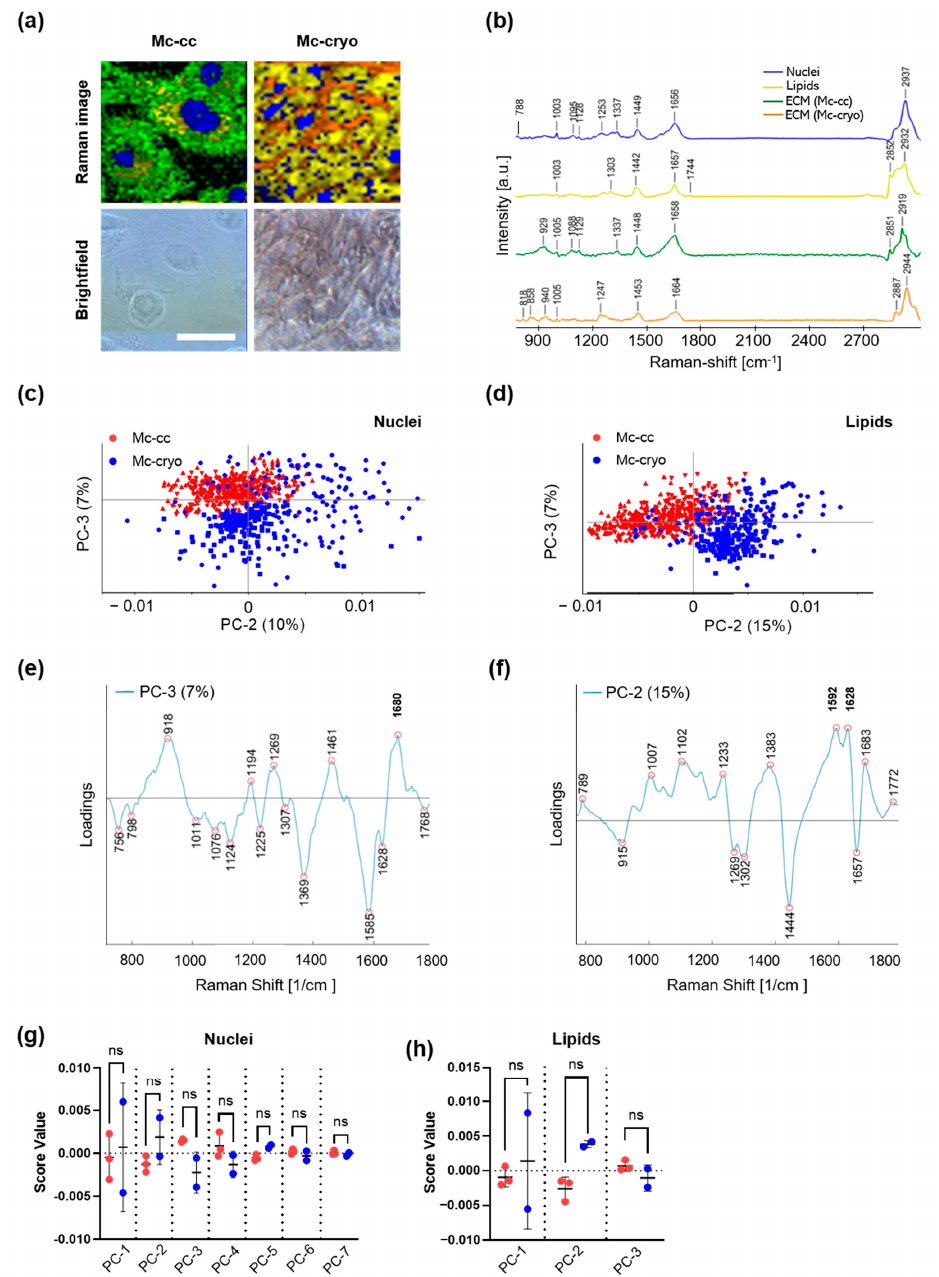
Figure 4. Raman imaging and multivariate data analysis of PWC-derived mesothelial cell culture (MC-cc) and cryo-fixed peritoneal tissue (MC-cryo). MC-cc were cultured on dishes, fixed with PFA and imaged in PBS using a customized upright WITec alpha300 R Raman system. MC-cryo were washed and imaged. MC-cc and MC-cryo were compared by multivariate data analysis with a focus on nuclei (DNA), lipids, and ECM components. ( a ) Representative Raman images and brightfield images of MC-cc and MC-cryo. Scale bar represents 50 µ m. ( b ) Characteristic fingerprint spectra of the analyzed molecular components, utilized to identify nuclei/DNA (blue), lipids (yellow) and ECM (MC-cc, green; MC-cryo, orange) components by TCA. ( c ) Principal component analysis (PCA) scores plot of PC2 vs. PC3 of extracted nuclei spectra showed trends of clustering between MC-cc and MC-cryo. ( d ) Scores plot of PC2 vs. PC3 of extracted lipid spectra indicates a trend of clustering between MC-cc and MC-cryo. ( e ) Loadings plot corresponding to nuclei-specific PCA indicates peaks that explain the trend of clustering in PC-3. ( f ) Loadings plot of lipid-specific spectral information highlights peaks responsible for the trend of clustering in PC2. ( g ) DNA-specific average score values for PC1 to PC7 showed no significant difference between MC-cc and MC-cryo. ( h ) Lipid-specific average score values for PC1-PC3 revealed no significant difference between MC-cc and MC-cryo. Results are shown as mean ± SD of PC score values, n = 3 (MC-cc) n = 2